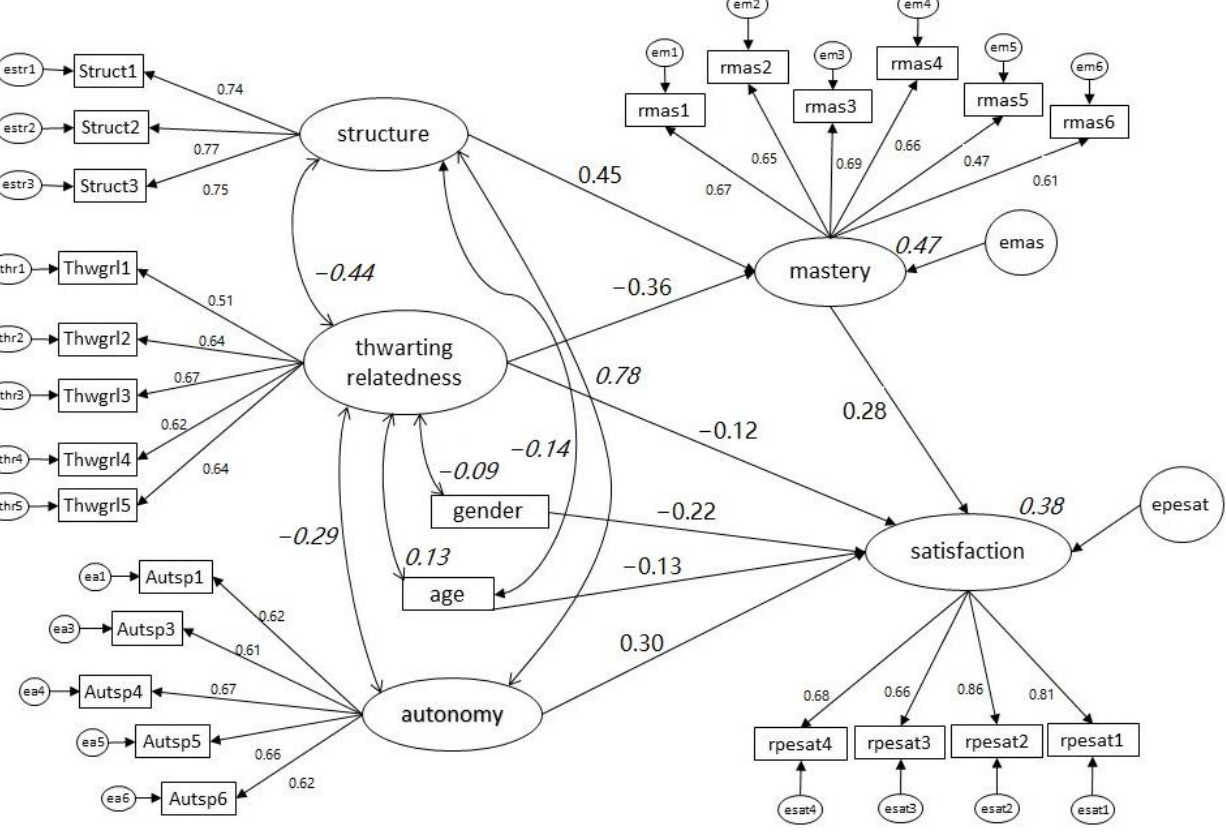
Figure 1. SEM model extracted from AMOS output investigating direct and indirect effects of per- ceived motivational climate dimensions, gender, and age on satisfaction in PE. Note: Coefficients in bold fonts in arrows indicate standardized beta weights and coefficients in italics fonts in curved lines indicate correlations. Only statistically significant ( p < 0.001) standardized beta weights and correlations are shown (except of thwarting relationships → satisfaction, p < 0.01 and the correlation between gender and thwarting relationships, p < 0.02). Squared multiple correlation for mastery = 0.47 and for satisfaction = 0.38.